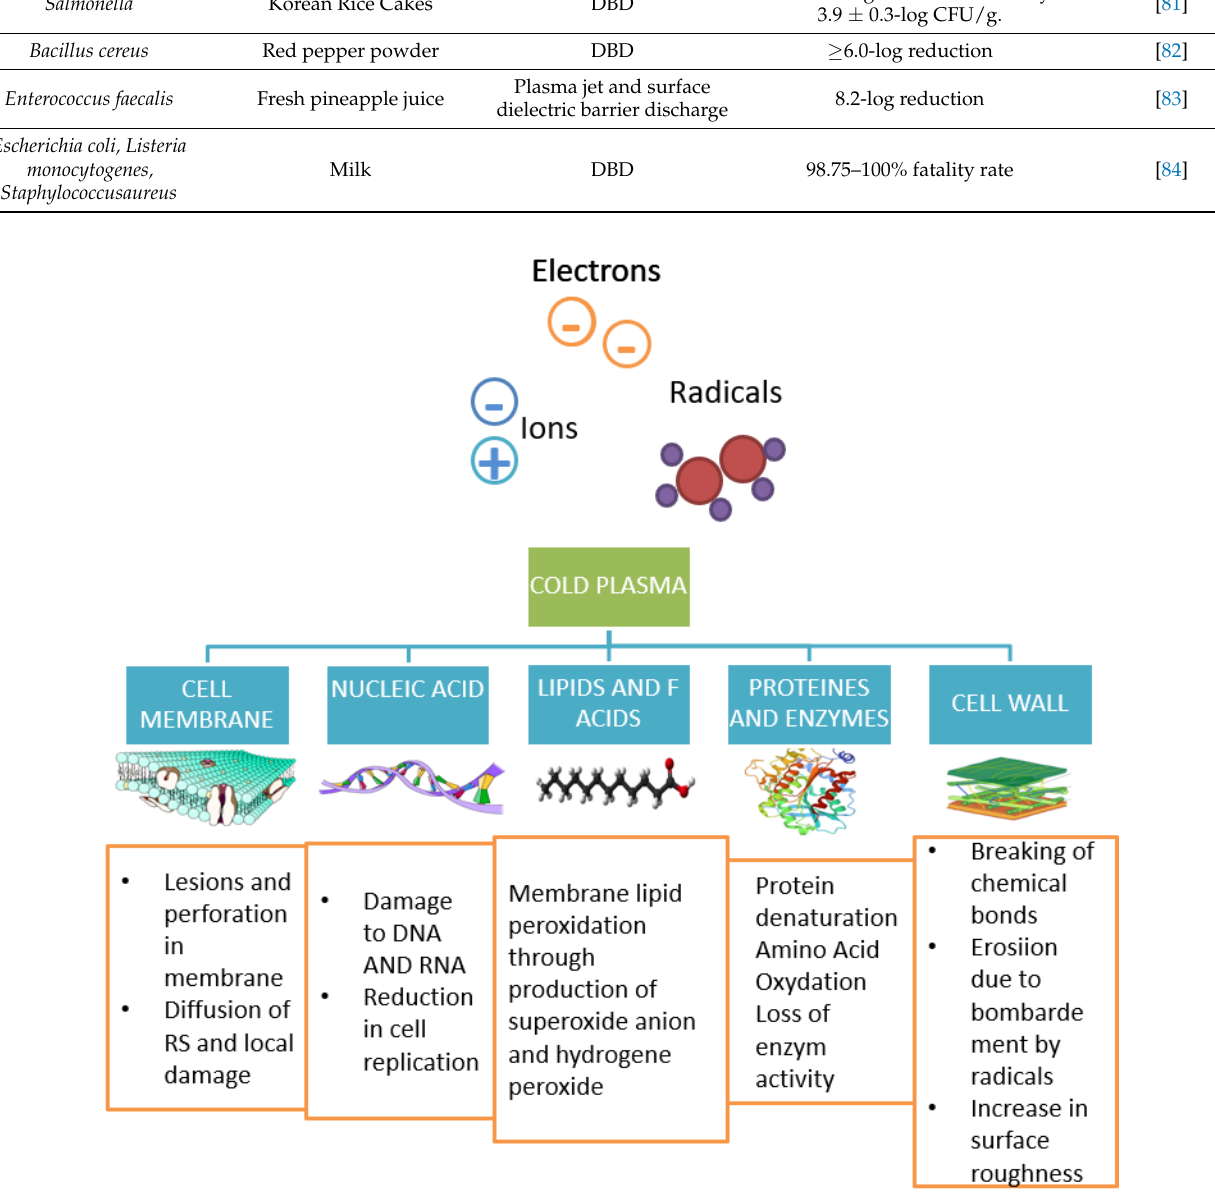
Figure 4. Mechanisms of bacterial inactivation with plasma reactive species [85].